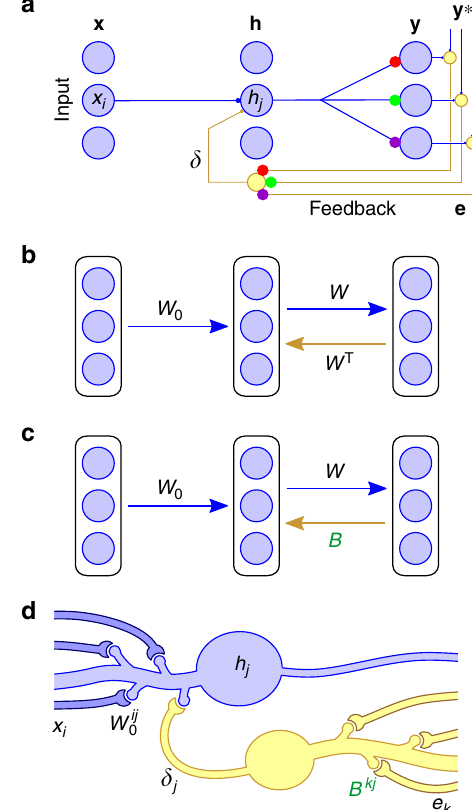
Figure 1 | Random feedback weights can deliver useful teaching signals. ( a ) The backprop learning algorithm requires that neurons know each others’ synaptic weights, for example, the three coloured synapses on the feedback cell at the bottom must have weights equal to those of the corresponding coloured synapses in the forward path. ( b ) Backprop computes teaching, or modulator, vectors by multiplying the error vector e by the transpose of the forward weight matrix W , that is, d BP ¼ W T e . ( c ) Our feedback alignment method replaces W T with a matrix of fixed random weights, B , so that d FA ¼ B e . Thus, each neuron in the hidden layer receives a random projection of the error vector. ( d ) Potential synaptic circuitry underlying feedback alignment, shown for a single hidden unit (matrix superscripts denote single synapses, see main text for further explanation). This diagram is provide for illustrative purposes. There are many possible configurations that could support learning with feedback alignment, or algorithms like it, and it is this structural flexibility that we believe is important. NATURE COMMUNICATIONS|7:13276|DOI: